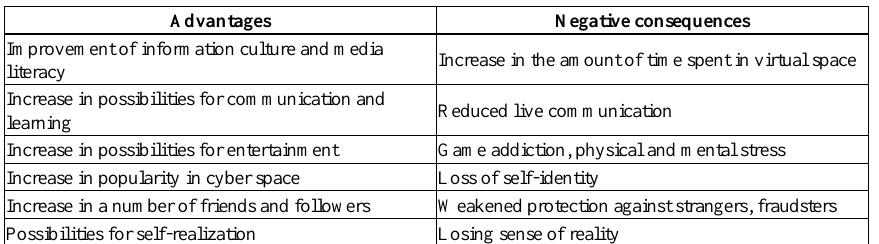
Table 4. Advantages and possible negative consequences of using